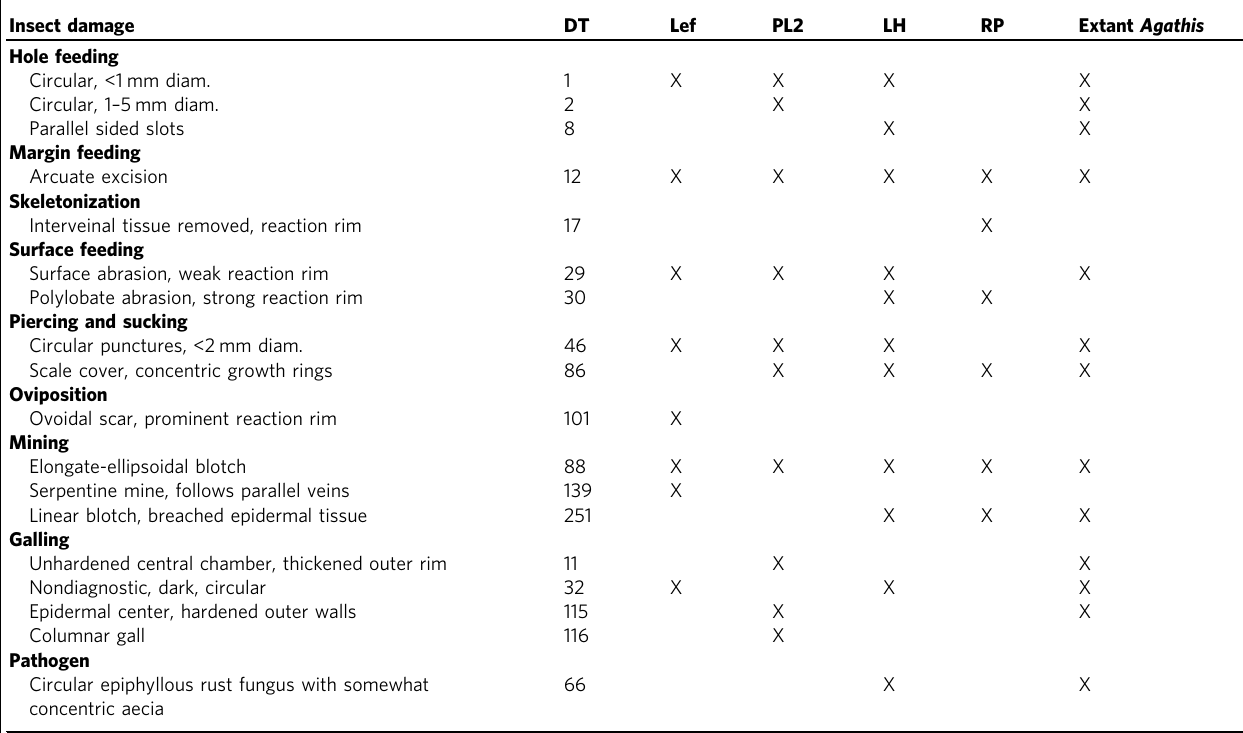
Table 1 Insect damage types on fossil and extant Agathis